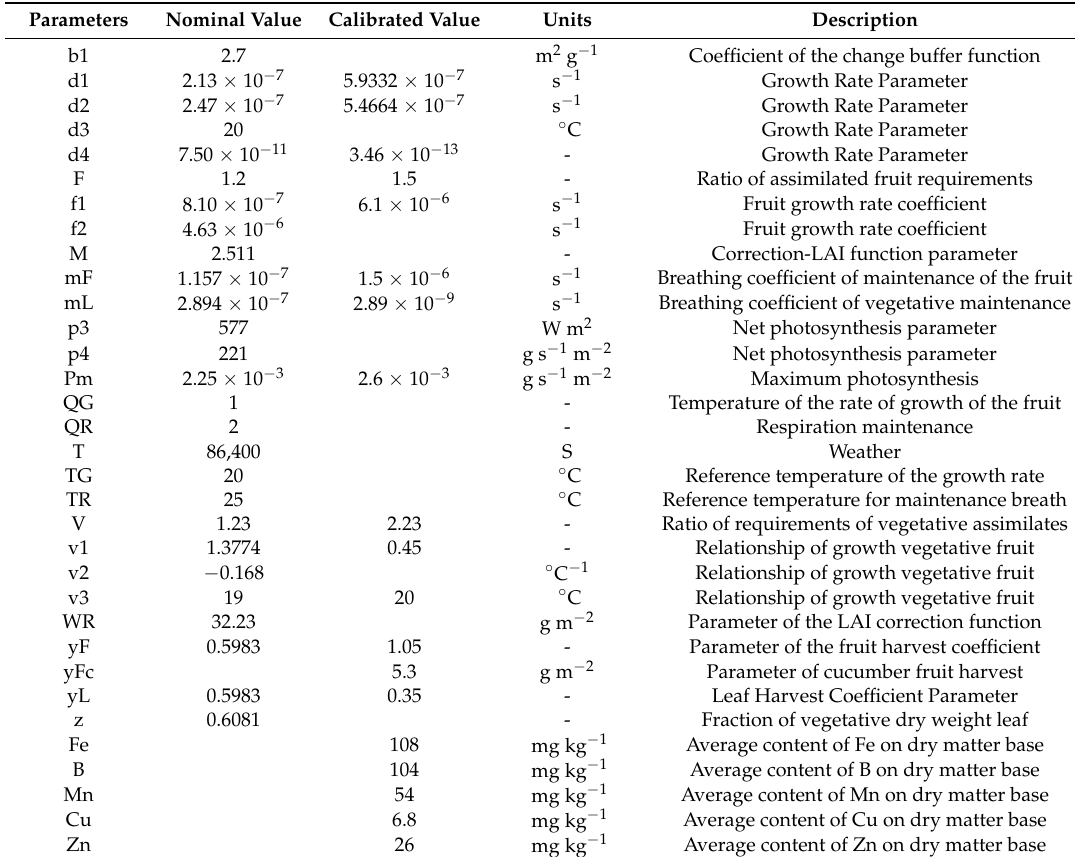
Table A1. Description of model parameters, nominal value and calibrated